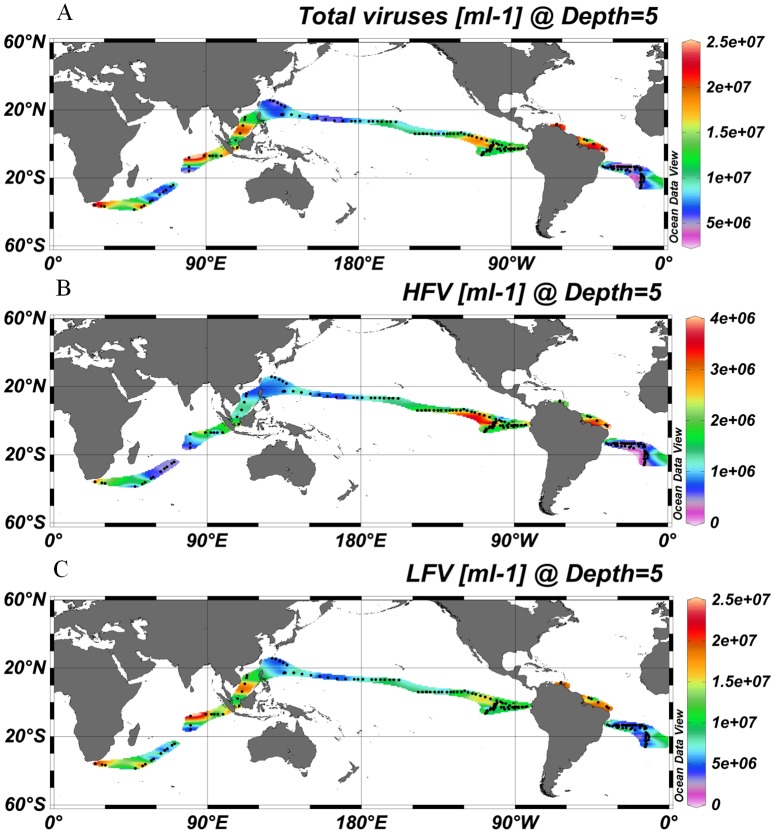
A global distribution pattern of the total viral abundance (A), HFV abundance (B) and LFV abundance (C).The map was generated with Ocean Data View software [40]. Abbreviations: HFV, high fluorescence viruses; LFV, low fluorescence viruses.